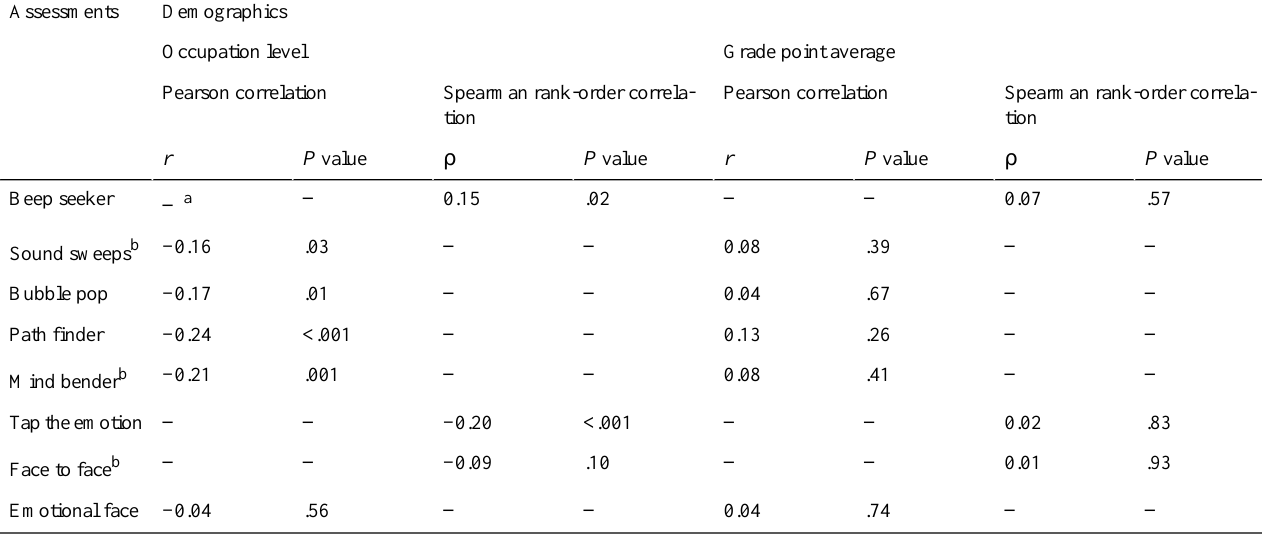
Table 4. Association of online neurocognitive assessments with demographic variables (occupation level and grade point